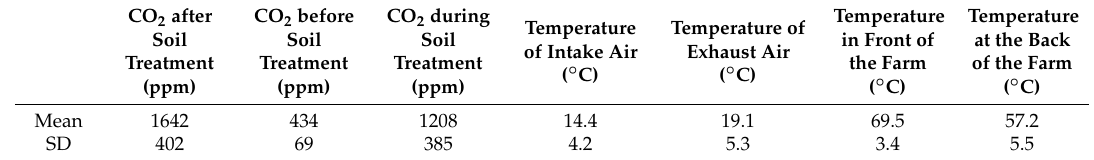
Table 1. Carbon dioxide concentration and temperature according to process of the night soil